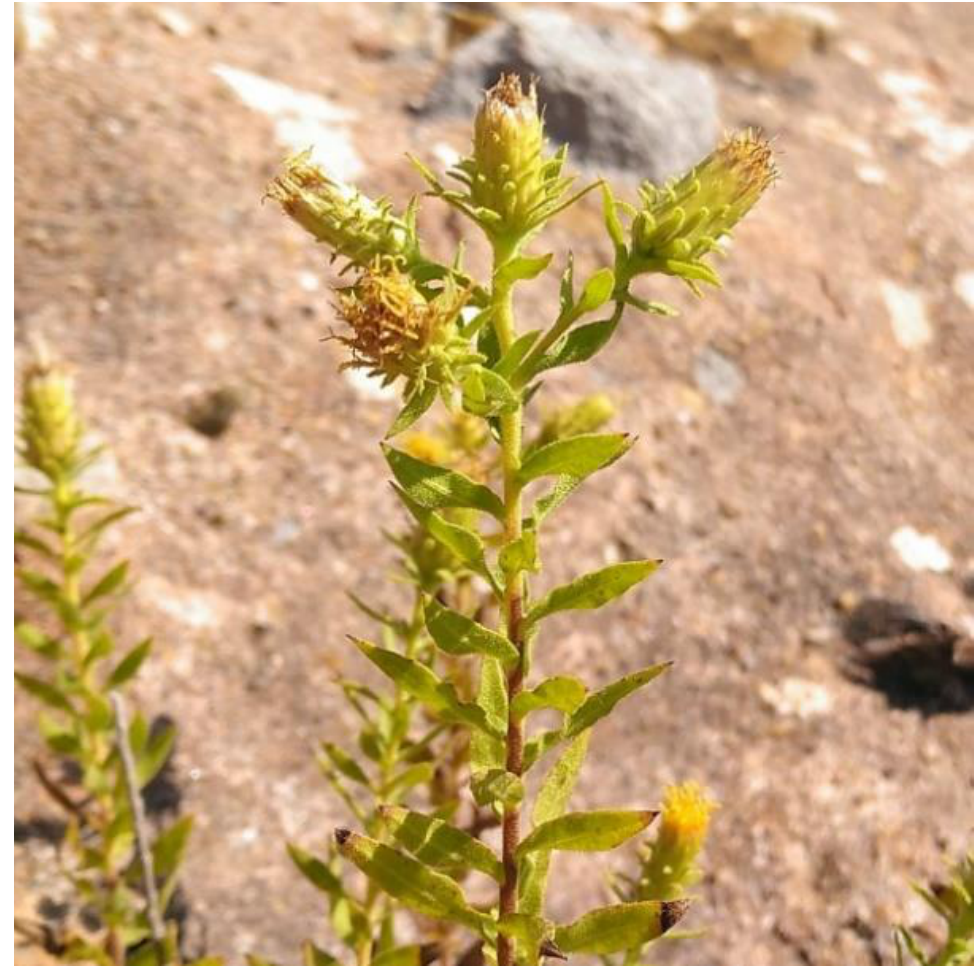
Figure 2. Flowering top of Chiliadenus glutinosus used in folk medicine and detail of the mature inflorescences. Photograph was taken in the town of Arnedillo (La Rioja).